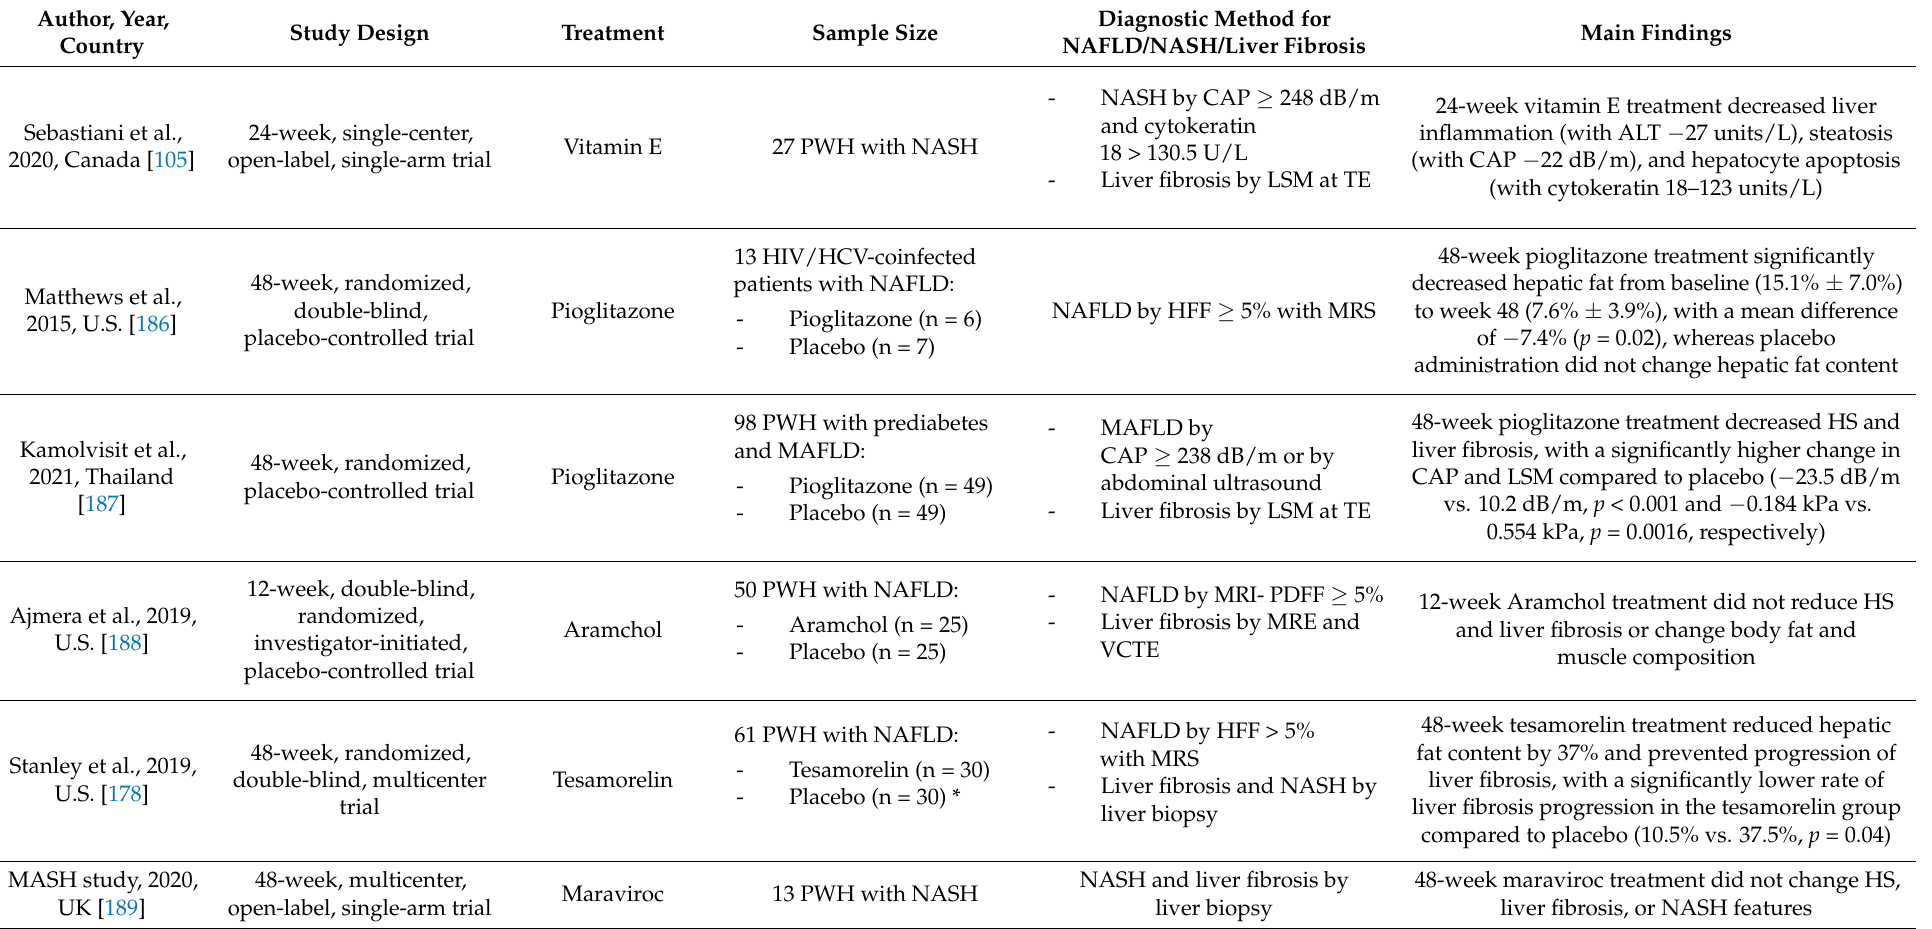
Table 4. Clinical trials evaluating the pharmacological treatment of NAFLD/NASH in people with